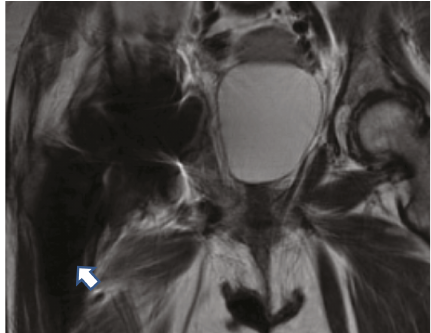
Figure 2: MRI right hip. Large air- and fl uid- fi lled collection tracking along the iliopsoas bursa and psoas muscle